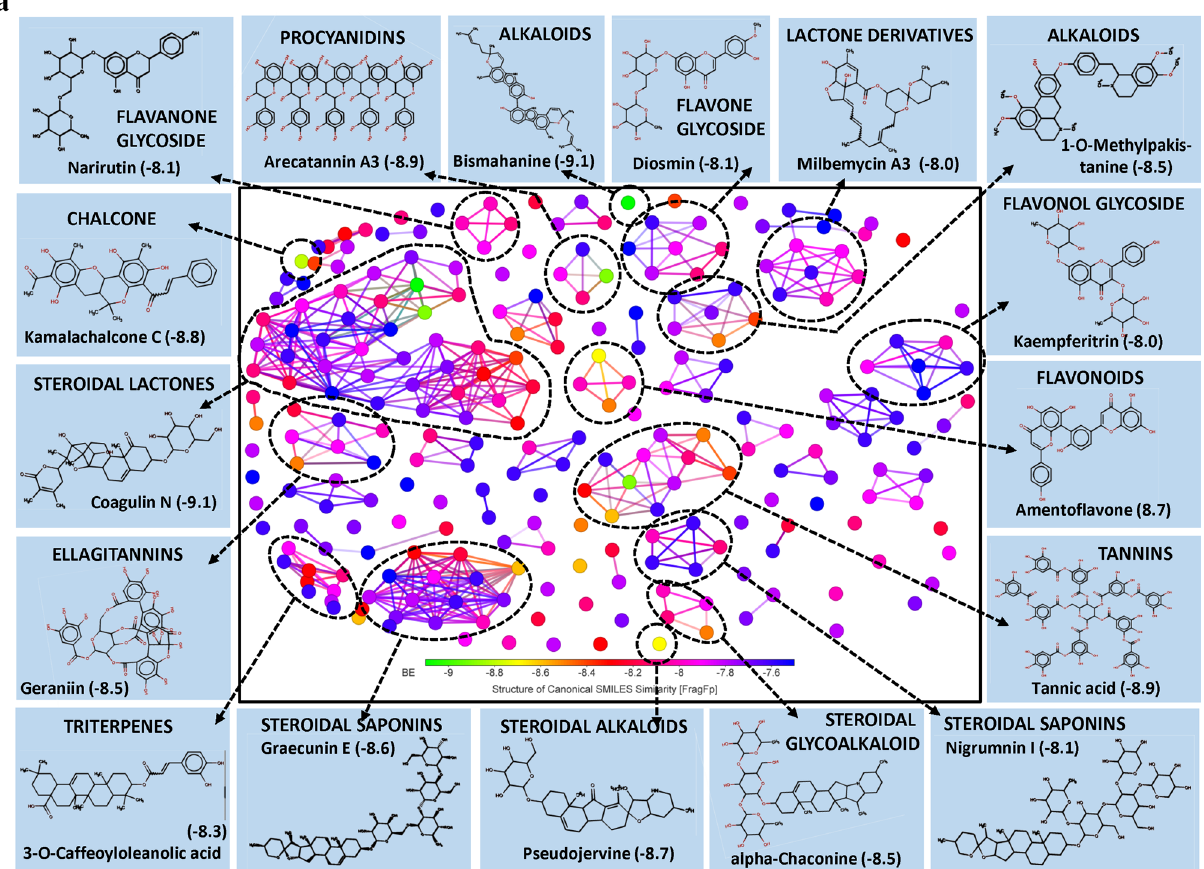
Figure 1. ( a ) Structural activity relationship: correlation of canonical SMILES structure similarity (data points are joined by colored lines) and binding energy (represented in different color shades of data point) of selected plant secondary metabolites (PSM) evaluated against SARS-CoV-2 spike protein using Data Warrior software. Structurally similar molecules are grouped in dotted lines and a representative molecule with low binding energy (kcal/mol) (values in parenthesis) is represented in box. More than 50% of the PSM among top 250 molecules studied belong to triterpenoids and their derivatives, with > 14% Sterol lactones. ( b ) Data analysis of selected PSM against SARS-CoV-2 spike protein. ( A ) Bioavailability radar chart representing lipophilicity (LIPO), Molecular weight (SIZE), Topological polar surface area (POLAR), Solubility (INSOLU), Flexibility (FLEX) and Saturation (INSATU) along with Bioavailability score (BAS) of selected molecules, ( B ) 3D visualization of protein–ligand interaction using PyMOL (selected amino acid residue of target site of protein are colored in cyan, and ( C ) 2D visualization of different types of interactions between ligand and target site of protein using Discovery Studio software (different types of interactions are represented in color